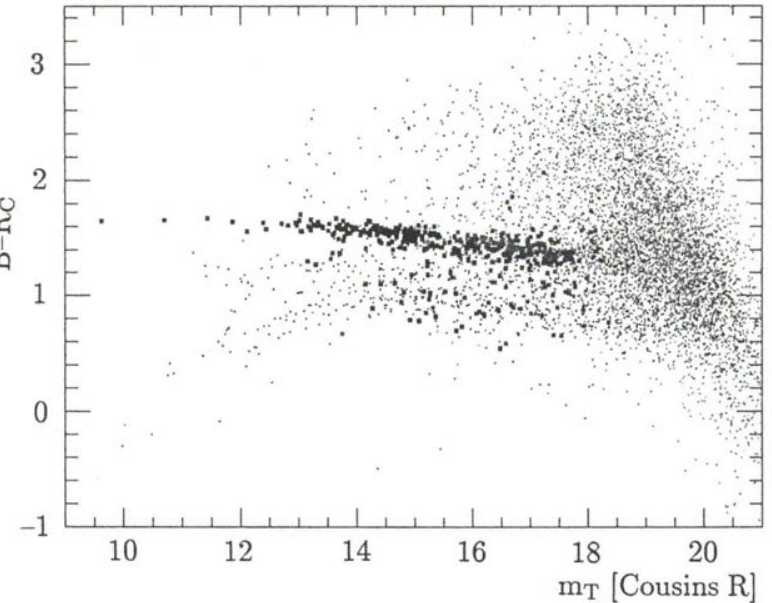
Fig. 14. Color-magnitude relation for the central 75 arcmin X 80 arcmin of the Coma cluster. Both stars and galaxies are included on this figure, a total of 15 370 objects. The lack of objects in the upper right hand corner is due to the combination of the magnitude limits in B and R Small black points - stars; black boxes - spirals and irregulars, confirmed members; dark grey boxes - E and SO galaxies, confirmed members; light grey boxes - unclassified confirmed members; small grey points - other galaxies in the field, members and non-members. The photometric data are from J0rgensen (2000). The redshift data are from J0rgensen & Hill